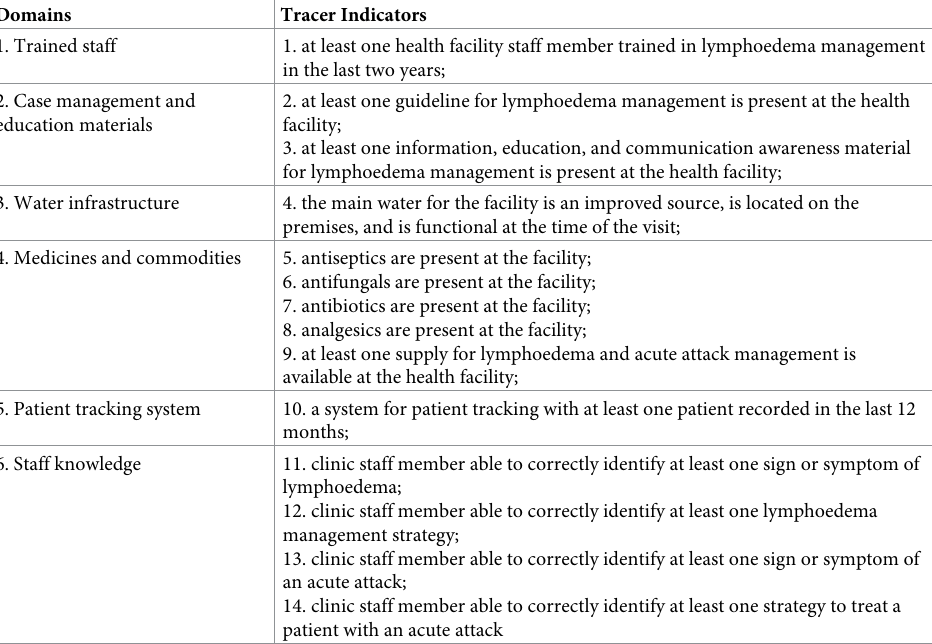
Table 1. Proposed quality domains and corresponding tracer indicators.